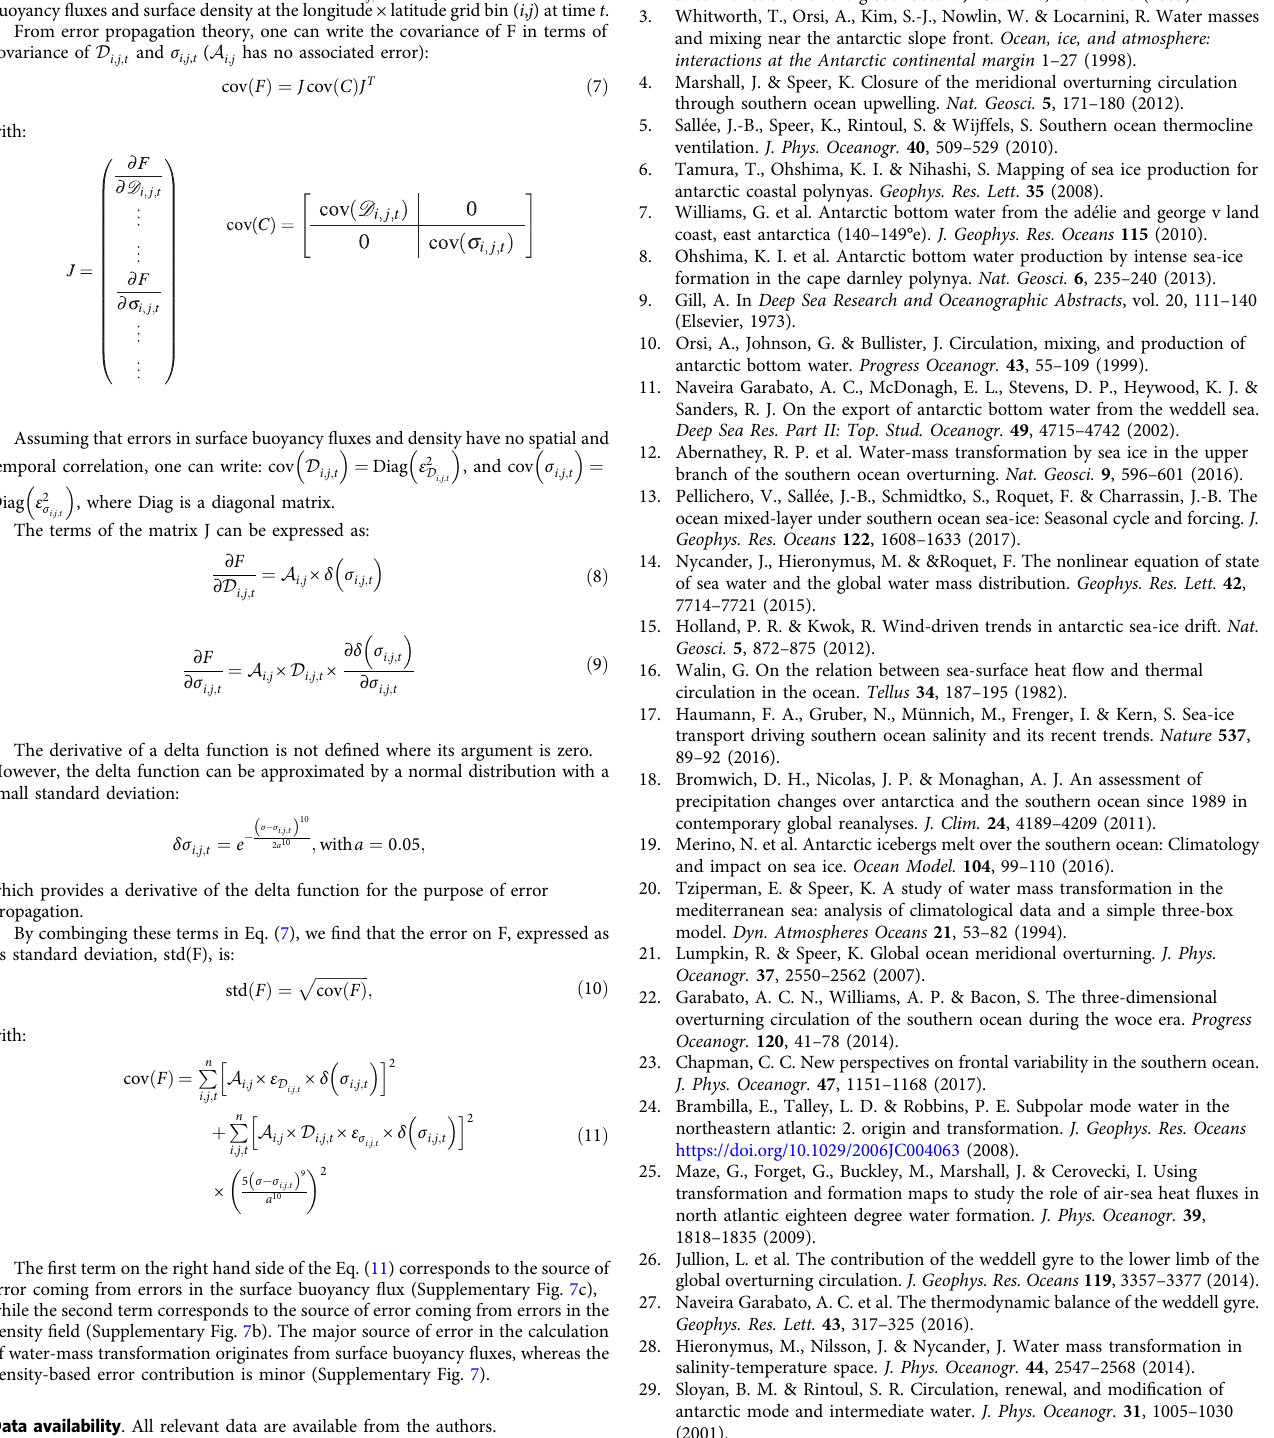
Data availability . All relevant data are available from the